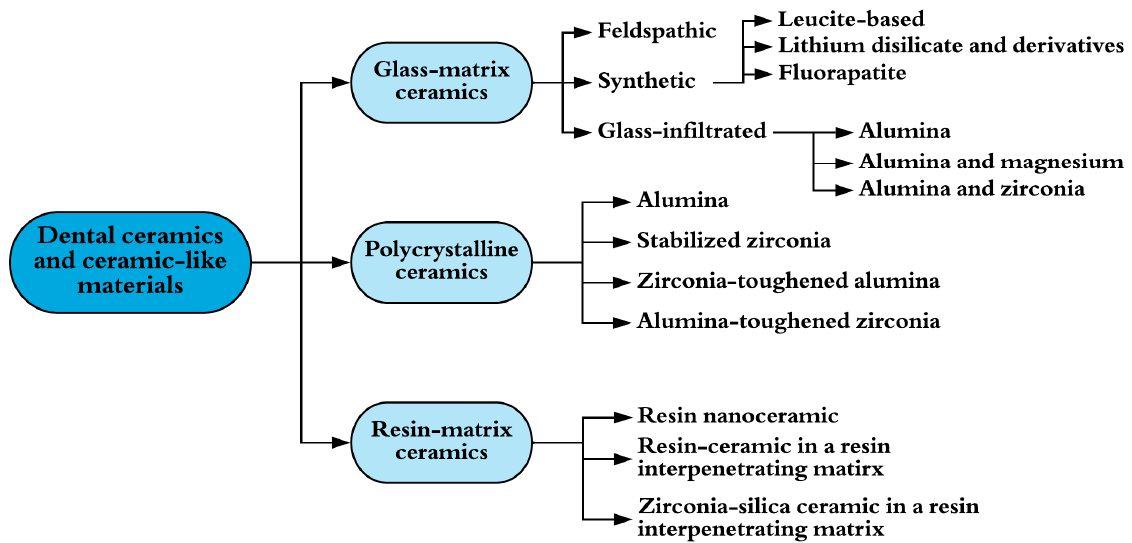
Figure 2. Classification system of ceramic and ceramic-like materials used in dentistry. Adapted from [38].